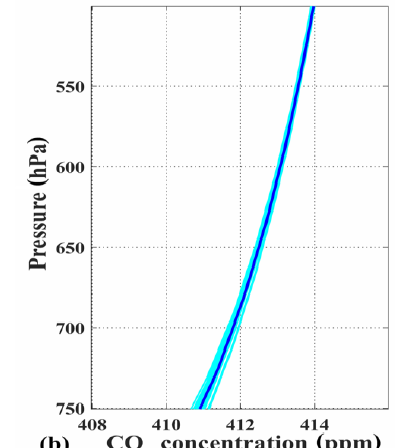
Figure 9. The distribution of OCO-2 satellite orbits in the flight area ( a ) and the CO 2 concentration vertical structure measured by the OCO-2 ( b ). In Figure 9a, there are two satellite orbits on 16 July and 18 July 2021 within the flight zone. The solid green line is the satellite orbit. The solid red line is the flight route of the plane on 16 July 2021. The green scatters represent the locations where the OCO-2 satellite data was sampled. In Figure 9b, the cyan solid lines represent the results at different heights for all CO 2 concentrations marked with green scatters in Figure 9a. The blue scatter points represent the average of all cyan solid lines at different heights (© Google Earth Pro).